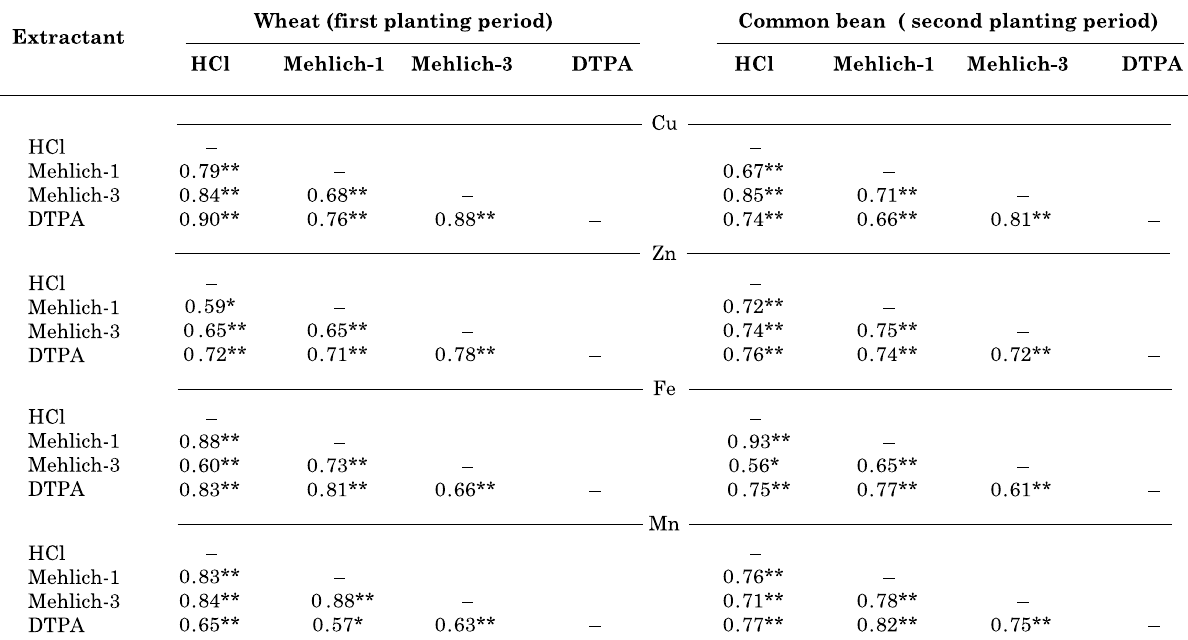
Table 2. Correlation among the different extractants tested to assess Cu, Zn, Fe, and Mn availability in 12 soils of Paraná under wheat and common bean (n =